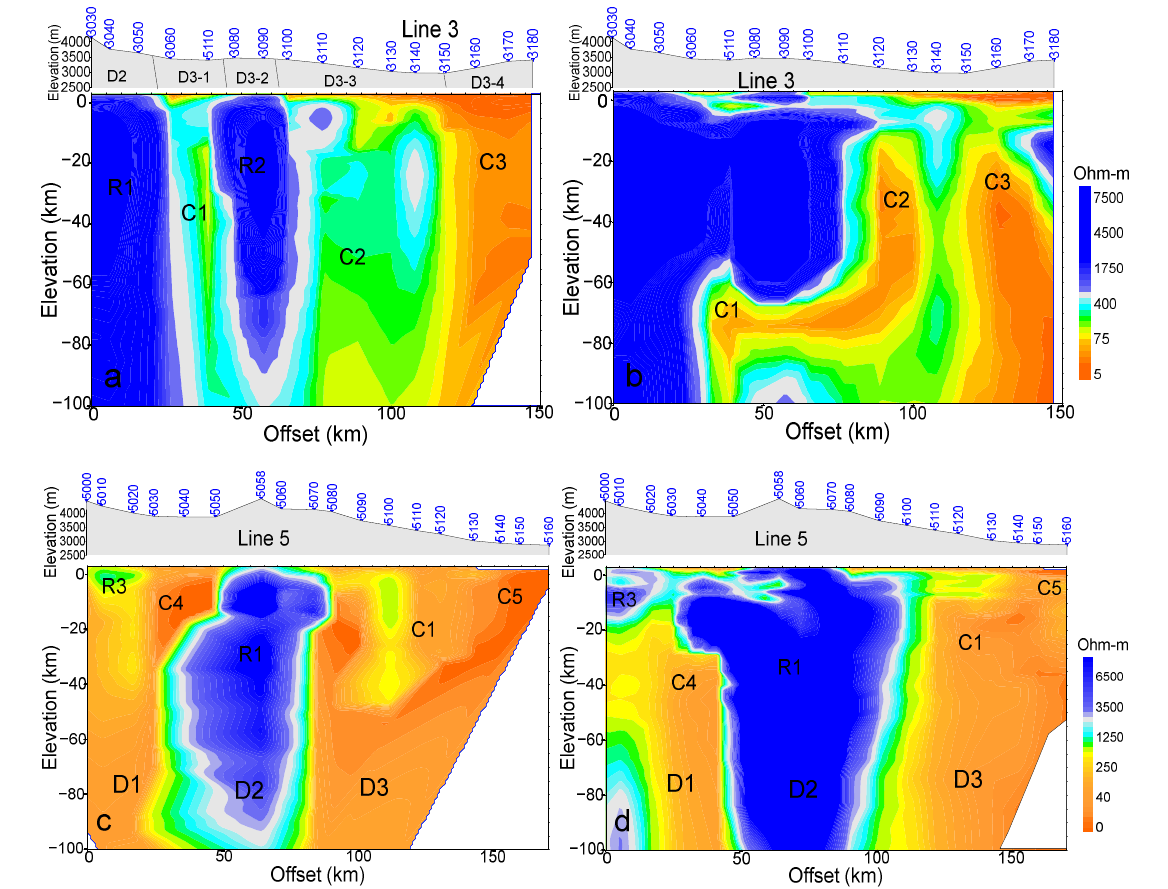
Figure 4. Resistivity conversion results of magnetotelluric (MT) sections Line 3 and Line 5 down to 100 km shows the crustal and upper lithosphere geoelectrical views of the Qimantagh Metallogenic Belt QMB. ( a ) and ( c ) show the result of Bostick conversion with electromagnetic array profiling (EMAP) filter. ( b ) and ( d ) are the result of nonlinear conjugate gradient inversion (NLCG). The blank area in the figures means limited penetration of less than 100 km (the high conductivity of the subsurface of the MT method has a limited depth of penetration).